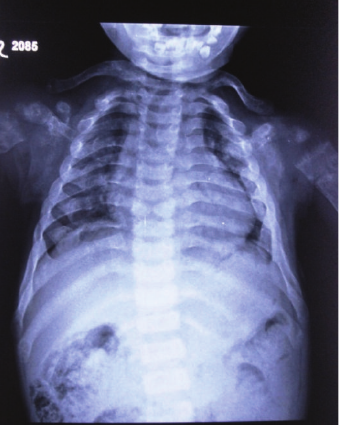
Figure 15: Chest